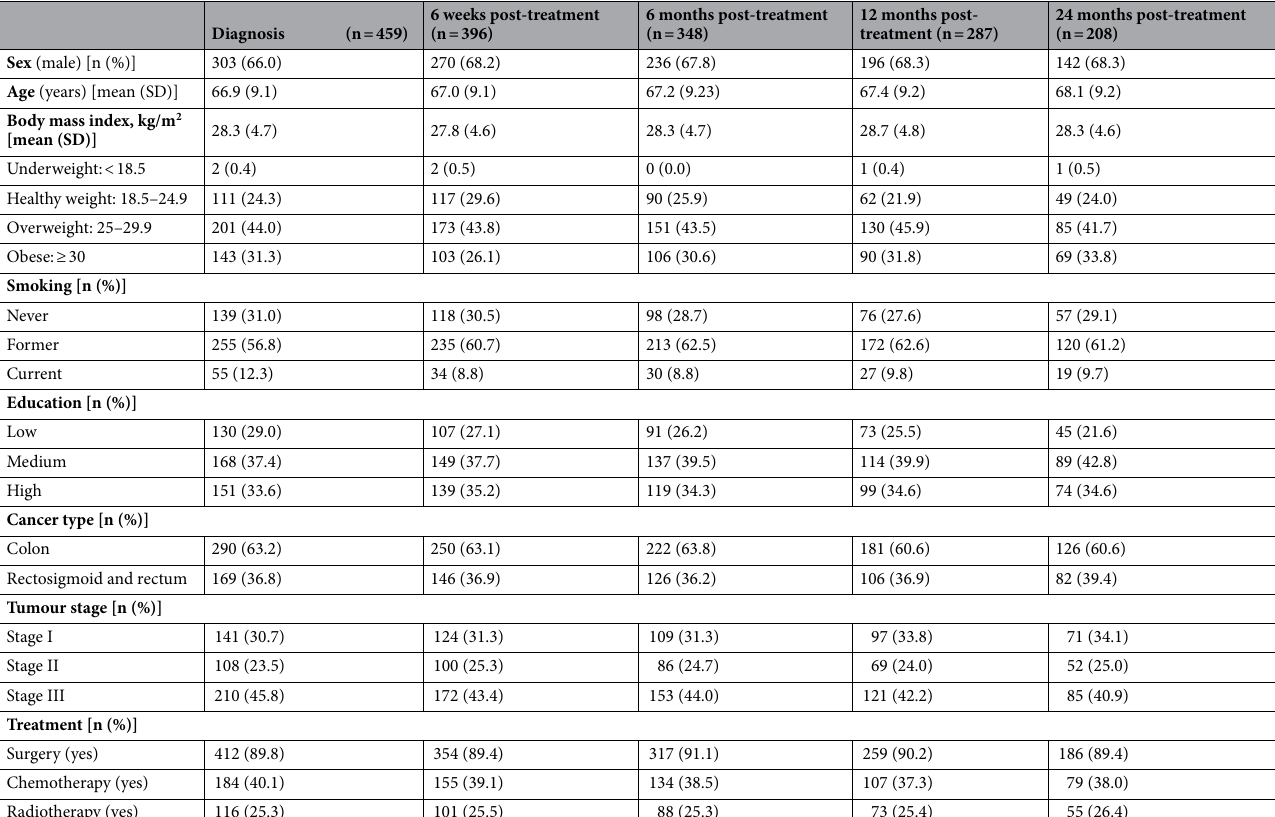
Table 1. Demographic, lifestyle, and clinical characteristics of colorectal cancer survivors at diagnosis, and 6 weeks, 6 months, 12 months, and 24 months post-treatment. BMI body mass index, SD standard deviation. a Percentages may not add to 100 due to rounding off. b Data missing for two participants